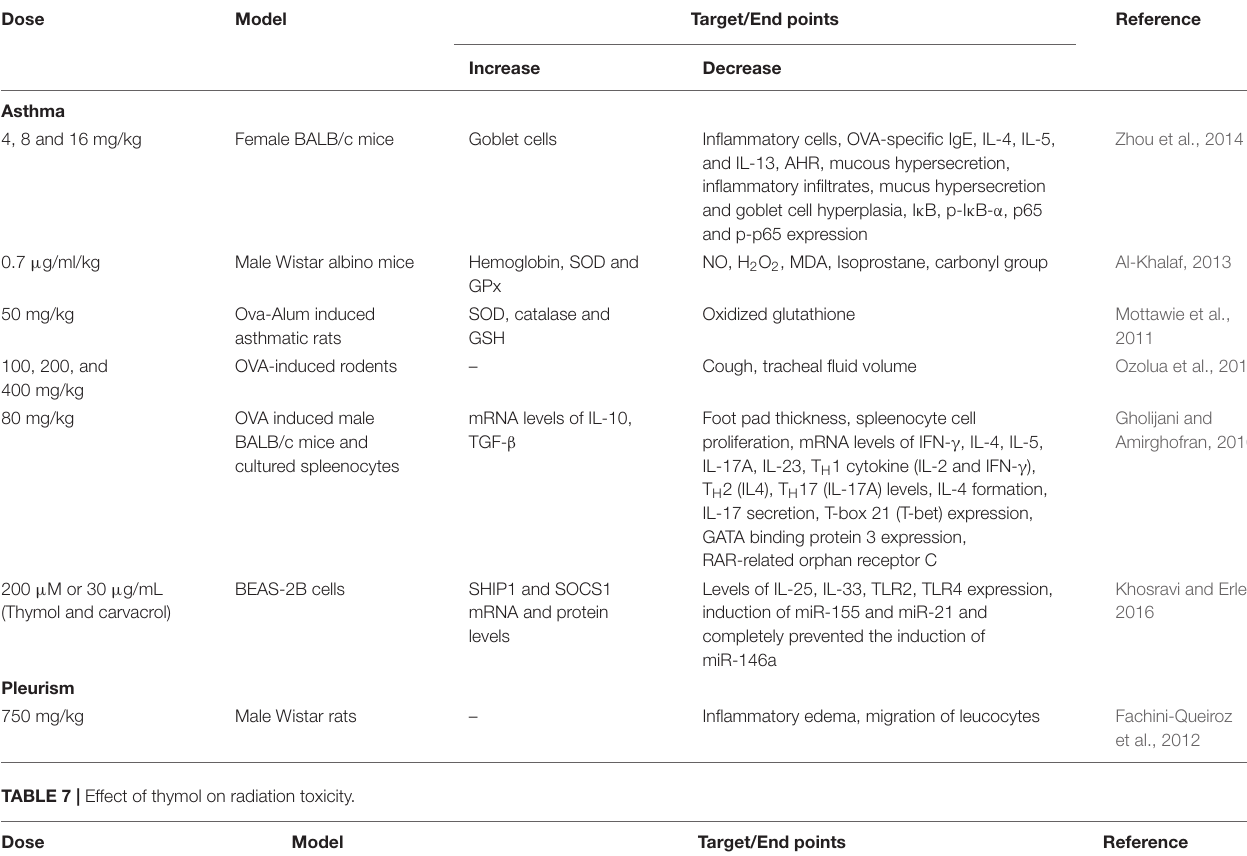
TABLE 6 | Effect of thymol in different experimental models of pulmonary diseases.